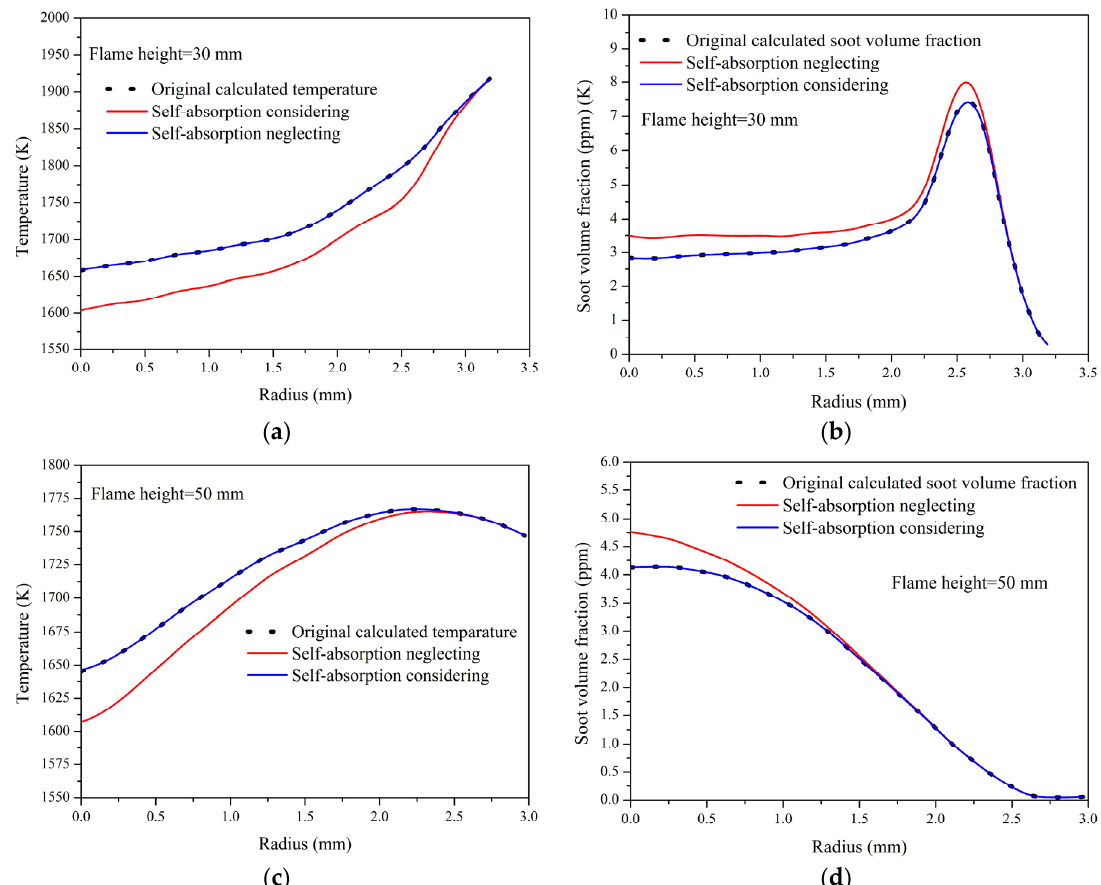
Figure 4. Iteration results with ( a ) temperature at 30 mm; ( b ) soot volume fraction at 30 mm; ( c ) temperature at 50 mm; and ( d ) soot volume fraction at 50 mm.